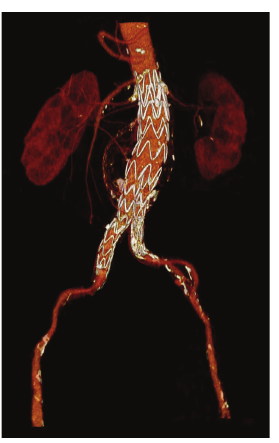
Figure 6: The angio-CT scan at the 3-month follow-up showing patency of renal stents and nice perfusion of both kidneys with no evidence of any